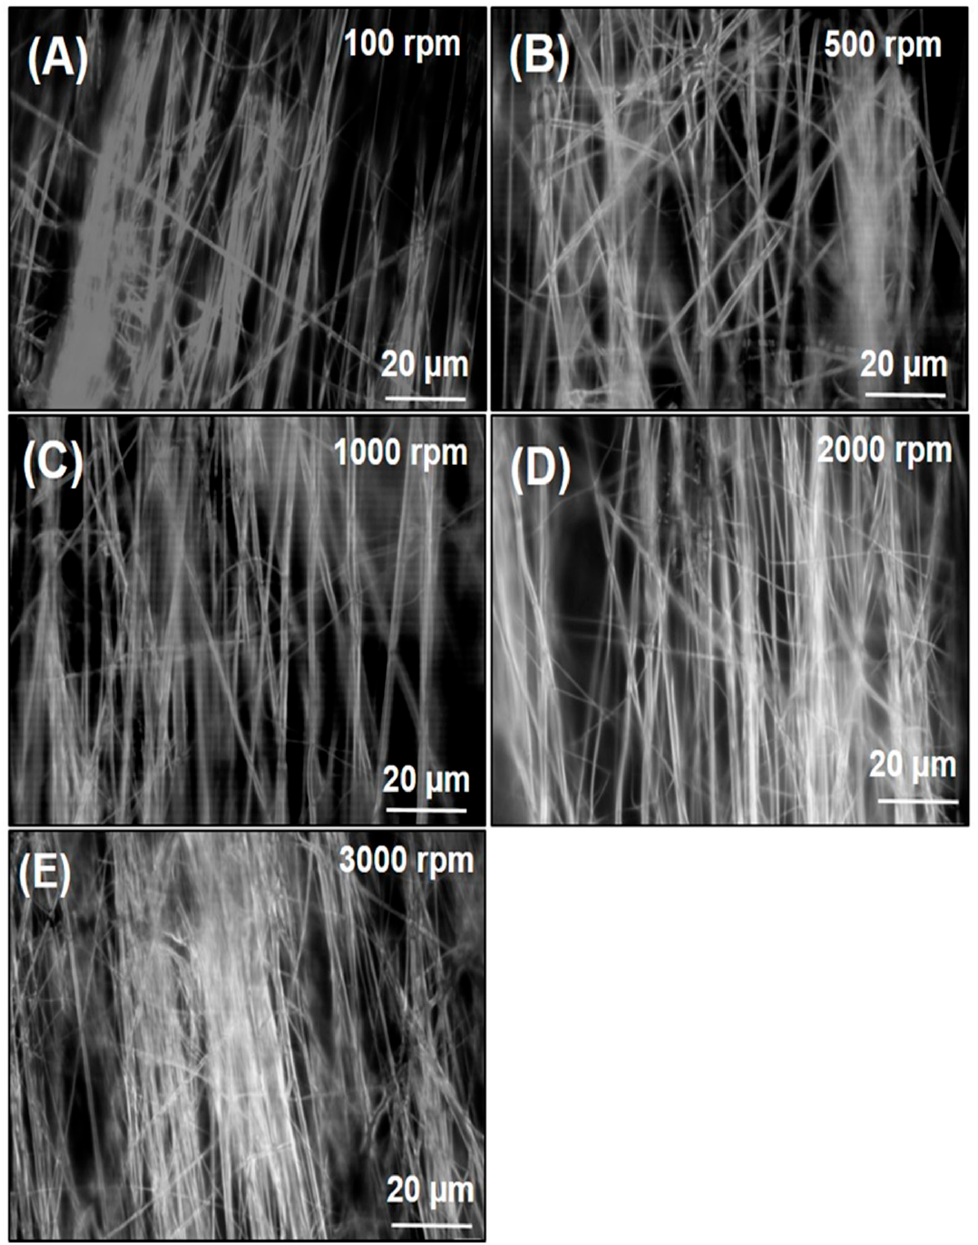
Figure 3. Morphology of as-spun precursor nanowires of CuCrO 2 thin films deposited on glass substrates at different rotating speed and annealed at 600 °C. Speed of rotation: ( A ) 100 rpm, ( B ) 500 rpm, ( C ) 1000 rpm, ( D ) 2000 rpm, ( E ) 3000 rpm.